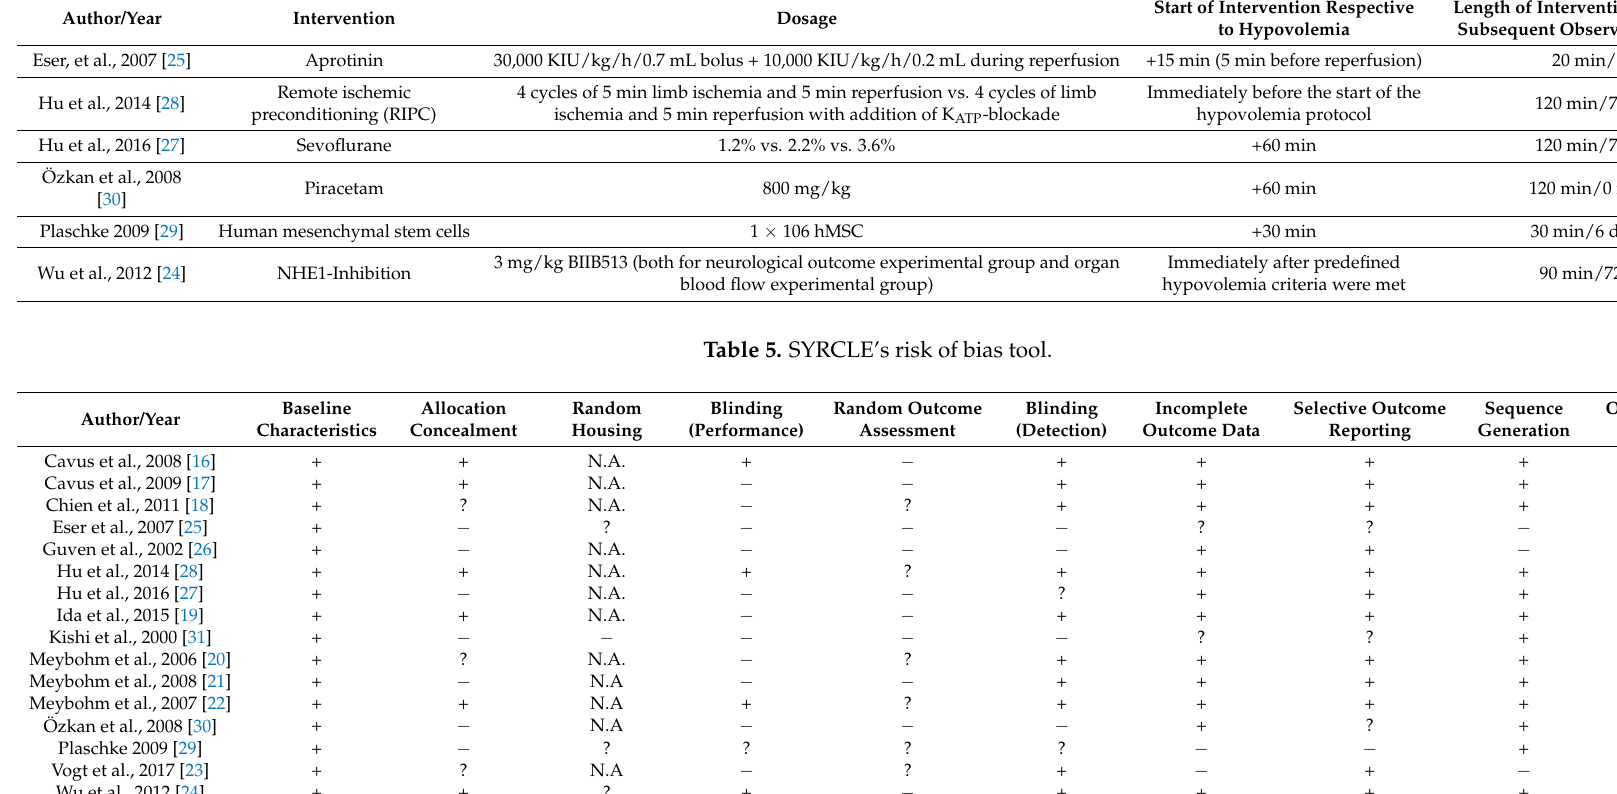
(+) indicates low risk of bias; ( − ) indicates high risk of bias; (N.A.) Not applicable; (?) indicates unclear risk of